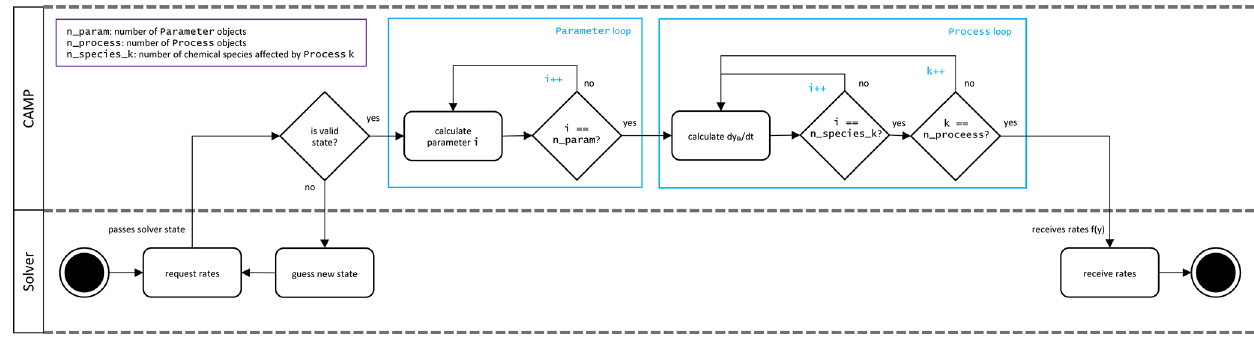
Figure 7. CAMP rate calculation workflow. Jacobian calculations follow a similar pattern.